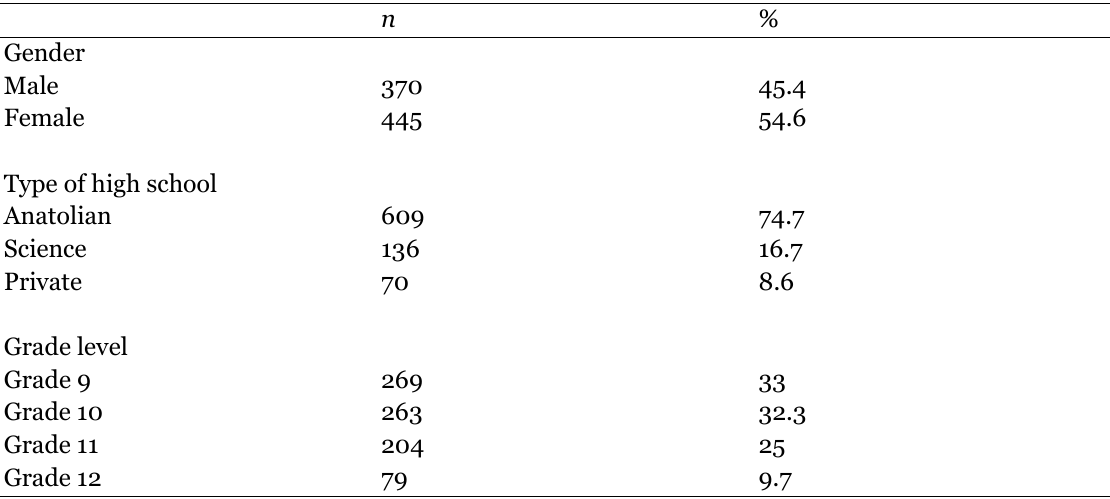
Individual and School Characteristics of Second Study Group